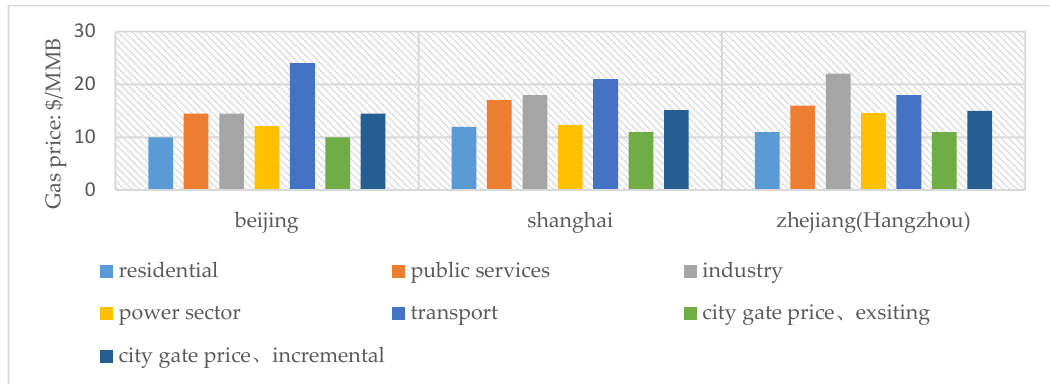
Figure 17. End user gas prices in Beijing, Shanghai and Zhejiang in the first adjustment period. Data Source: CNPC (2014), NDRC (2013).